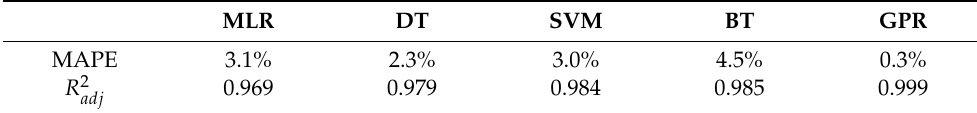
Figure 7. Performance of each regression model. ( a ) MLR. ( b ) DT. ( c ) SVM. ( d ) BT. ( e ) GPR. Table 2. MAPE and 𝑅 𝑎𝑑𝑗2 results of five regression algorithms.